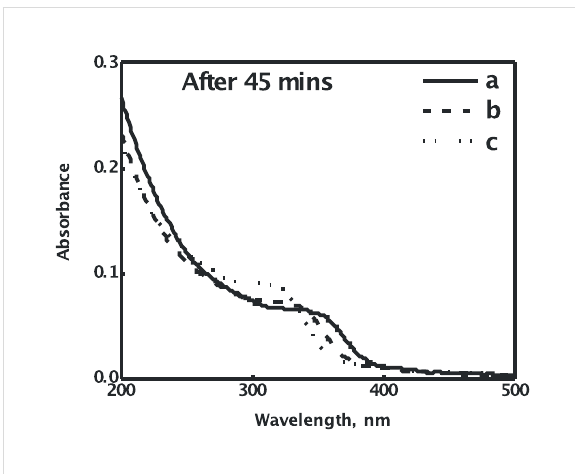
Figure 3: Absorption spectra of PVA-capped CdSe quantum dots, synthesized by the reaction of a fixed Na 2 SeSO 3 concentration of 1 × 10 − 3 mol dm − 3 with various concentrations of Cd(AcO) 2 , (a) 2 × 10 − 3 mol dm − 3 , (b) 4 × 10 − 3 mol dm − 3 , and (c) 5 × 10 − 3 mol dm − 3 , in the presence of 9.2% PVA, at 27 °C.